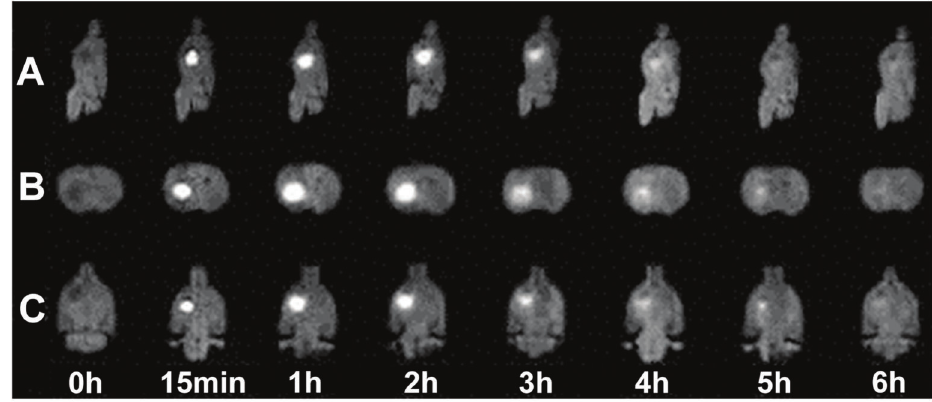
Figure 1. Spatiotemporal distribution of gadolinium-diethylenetriamine pentaacetic acid (Gd-DTPA) injected into the 10-day glioma. Sagittal views ( A ), axial views ( B ), and coronal views ( C ) over time before and after injection of Gd-DTPA.